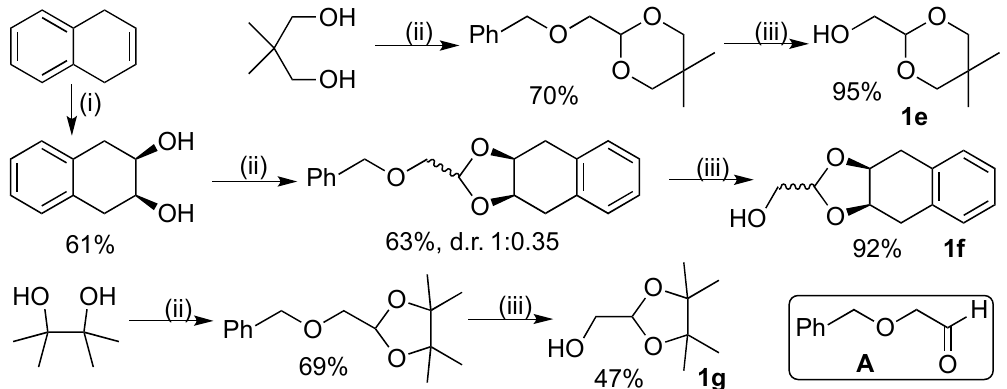
Scheme 5. Synthesis of compounds 1e - g . Reagents and conditions: ( i ) NMO ( N -methylmorpholine N - oxide), OsO 4 cat. , t BuOH/acetone/H 2 O, rt; ( ii ) A , TsOH cat. , toluene, reflux; ( iii ) H 2 , Pd/C cat. , MeOH, rt.